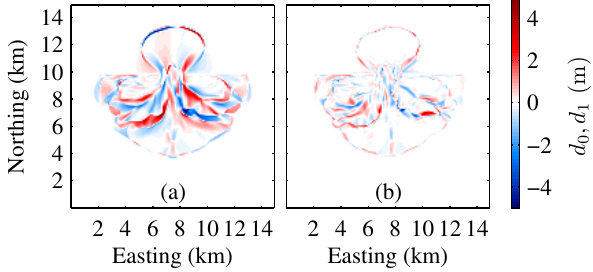
Easting (km) Fig. 4. Point-wise error fields for the predicted depth field at 0 ◦ : (a) the total error d 0 = p 0 − o before the warp; (b) the error d 1 = p 1 − o after the warp, to be regarded as the remaining point-wise error if no penalty applies for location